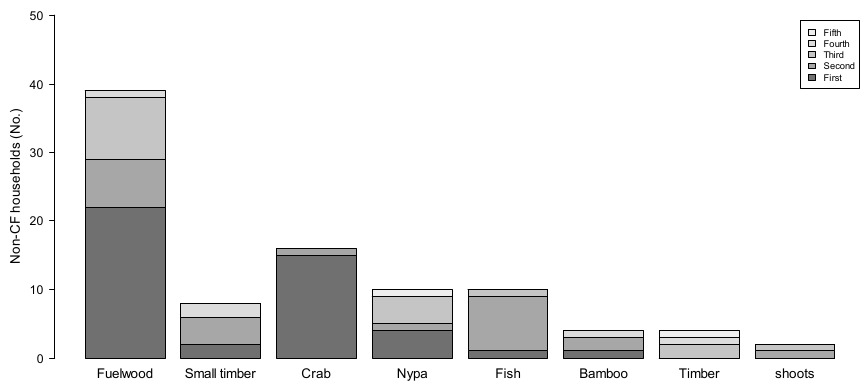
Figure 5. Use and importance of mangrove products by non-members of the CFUG.